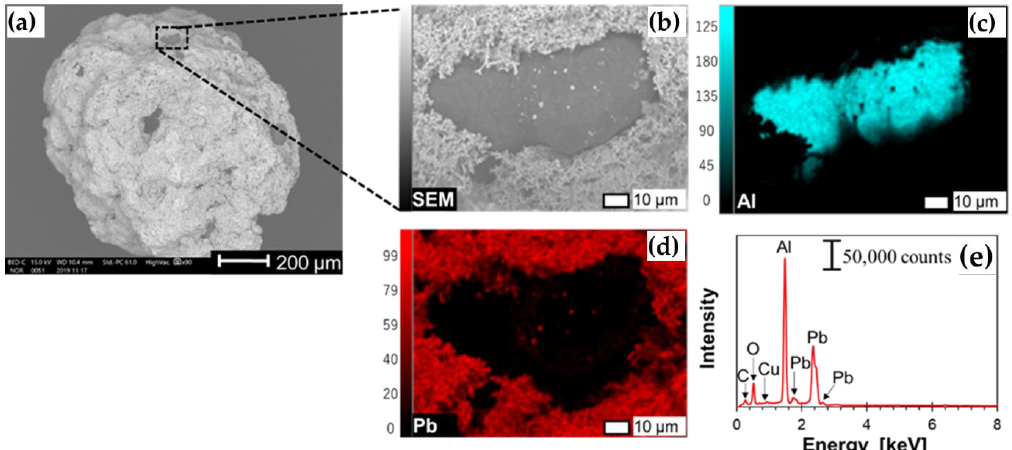
Figure 5. SEM-EDX of ZVAl “coated” with Pb from the + 150 µ m particles obtained after sieving the leaching pulp when ZVAl was added during leaching of ZPLRs: ( a ) SEM image of + 150 µ m particles, ( b ) zoomed SEM image, EDX elemental mapping of ( c ) Al and ( d ) Pb, as well as ( e ) EDX spectra. Metals 2020 , 10 , x FOR PEER REVIEW